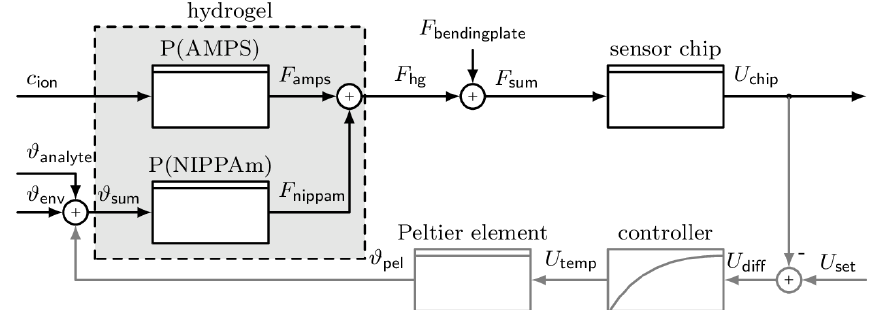
Figure 3. Block diagram of the hydrogel sensor. The hydrogel consists of two polymers, each influenced by a different stimulus, P(AMPS) by ion concentration c ion and P(NIPAAm) by temperature ϑ sum . The force F hg caused by the swelling of the hydrogel is converted into a voltage U chip by the sensor chip. To use the force compensation, the grey path is added, where a certain deflection can be set with U set . Then the controller changes the temperature of the Peltier element ϑ pel to adjust the degree of swelling.